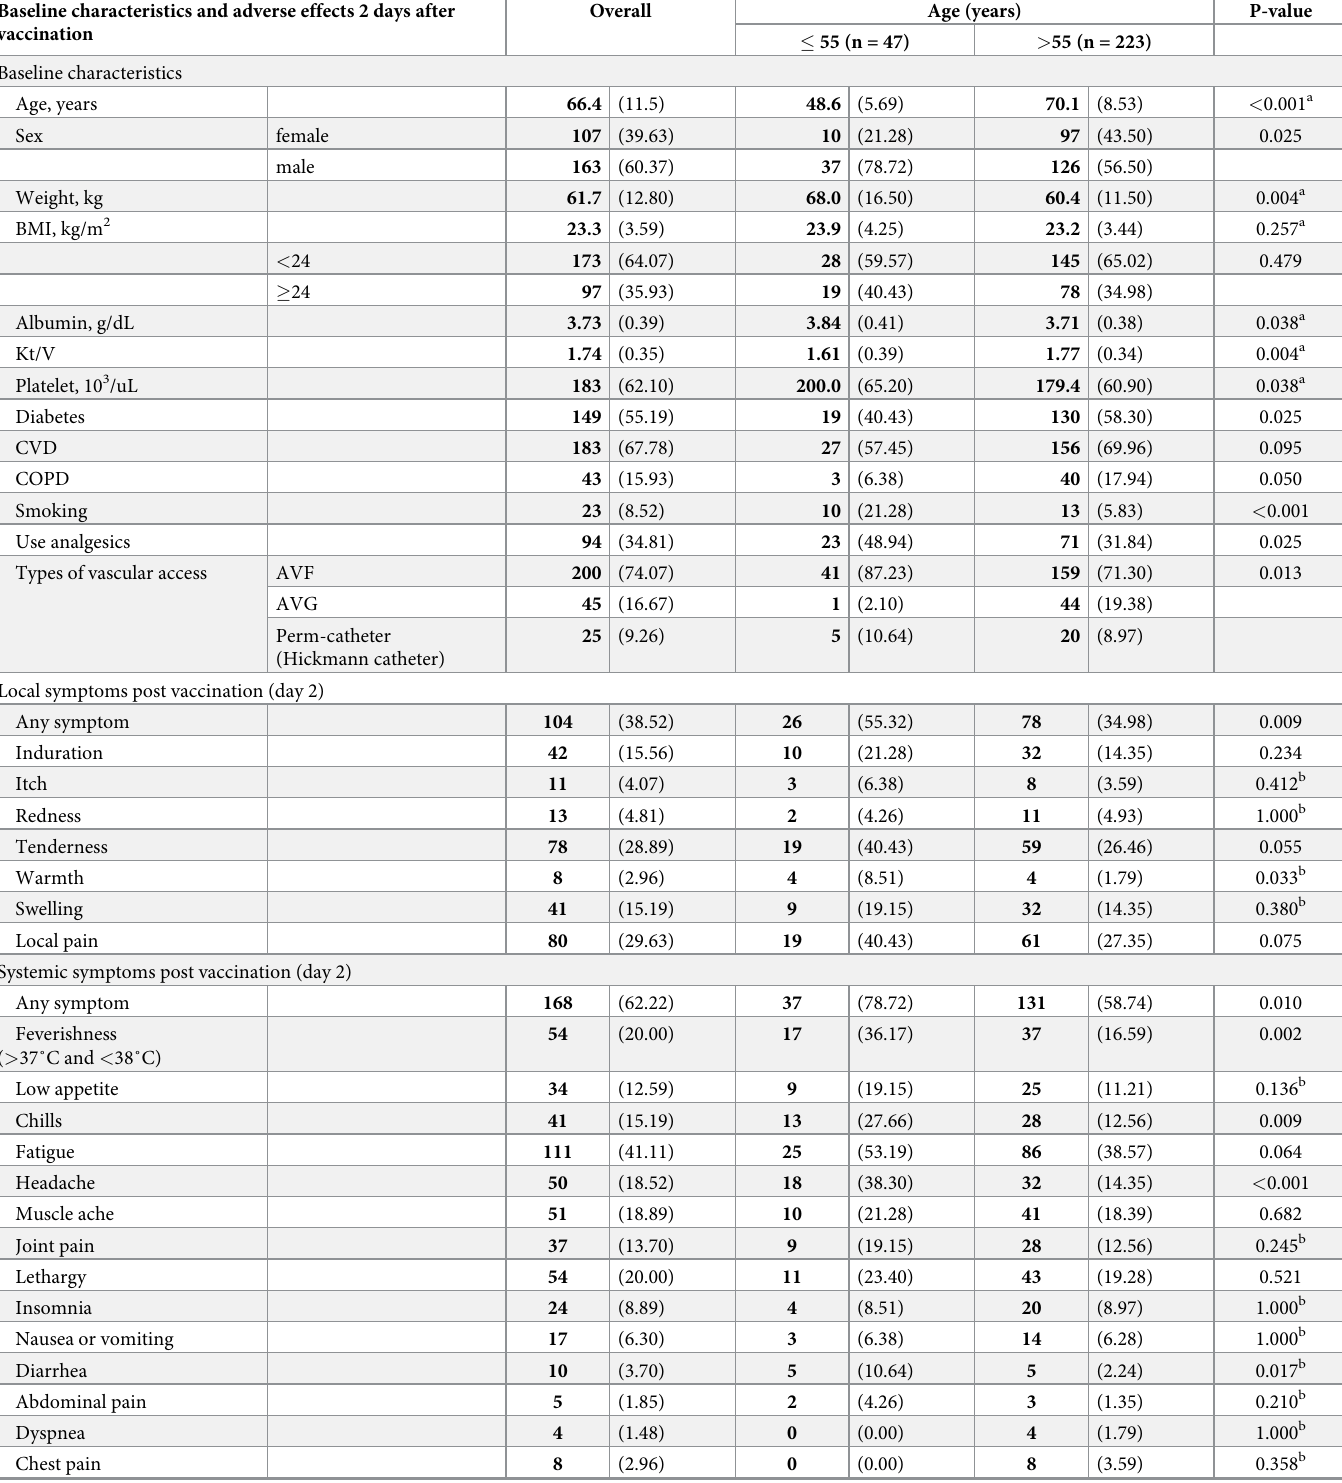
Table 1. Baseline characteristics and adverse effects on day 2 of ChAdOx1 nCoV-19 (Oxford-AstraZeneca) vaccination (first dose) in ESRD patients on hemodialy- sis (N = 270). Baseline characteristics and adverse effects 2 days after